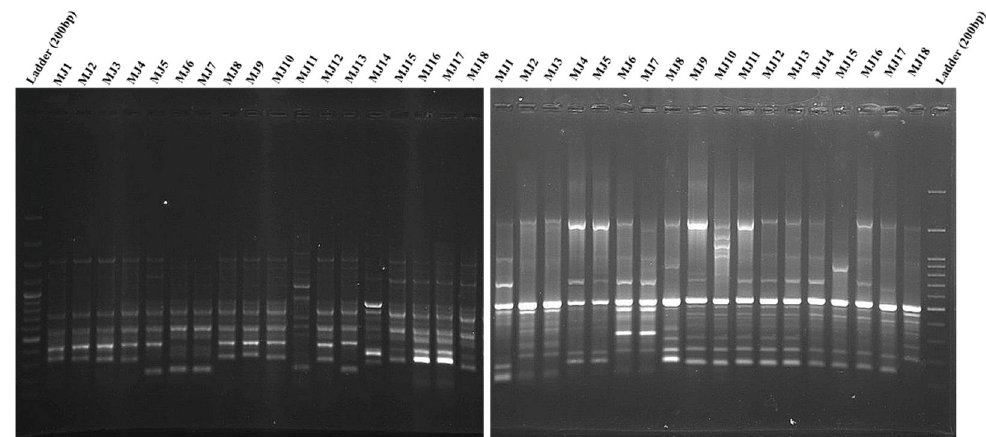
Figure 3. The patterns of RAPD ( left ) and ISSR ( right ) for 18 Meloidogyne javanica populations by using CCA5 and OPA10 primers. DNA Ladder = 200 bp. (For population codes, see Table 1). For each primer in ISSR, 168 loci, with an average of 16.8 loci were determined; polymorphic and monomorphic bands were 138 (82.14%) and 32 (19.04%), respectively. The bands were produced from 13–20 with an average of 16.8 per primer. The ranges of polymorphic and monomorphic bands between primers were 11–17 (average: 13.8) and 1–6 (average: 3.2), respectively (Table 4 and Figure 3 right). A high similarity in general topology was obtained in UPGMA trees with RAPD and ISSR data and in both of them, four main clades were created; however, the position of a few populations was different. Finally, a dendrogram was created by combining the data sets of RAPD and ISSR, as presented in Figure 4. Bootstrap values were written only for main clades. On the other hand, the ∆ k statistic gave the highest value at k = 4 ( ∆ k = 431), and all 29 populations belonged to four genetic clusters (Figure 5). Placement comparison of the populations in four main clades of UPGMA dendrogram and four clusters of structure analyses revealed that there was a high similarity between the two methods. Bar graphs showing genetic diversity structure are placed in front of the dendrogram. Each cluster and the related clades of them in the dendrogram are represented by a different color (blue, green yellow, and red) and labeled as groups 1–4. The average of the Q value was 0.86, 0.83, 0.71, and 0.80 for groups 1–4, respectively. All populations were defined in four groups based on their positions in four clusters, and frequency, AMOVA, and PCoA analyses were carried out. Group 1 contained eleven populations (MJ1–7 and MJ26–29) and all of them were collected from three northwestern provinces of Iran (Ardabil, East Azerbaijan and West Azerbaijan) (Table 1; Figures 1 and 4). Values of P, I, H and uHe (27.43%, 0.167, 0.115 and 0.121) revealed that this group, with about 12.1%, exhibited the highest genetic diversity, as compared to that of the other three groups (Table 5). Northwestern region of Iran is a mountainous region with a cold to the temperate climate and semi-humid